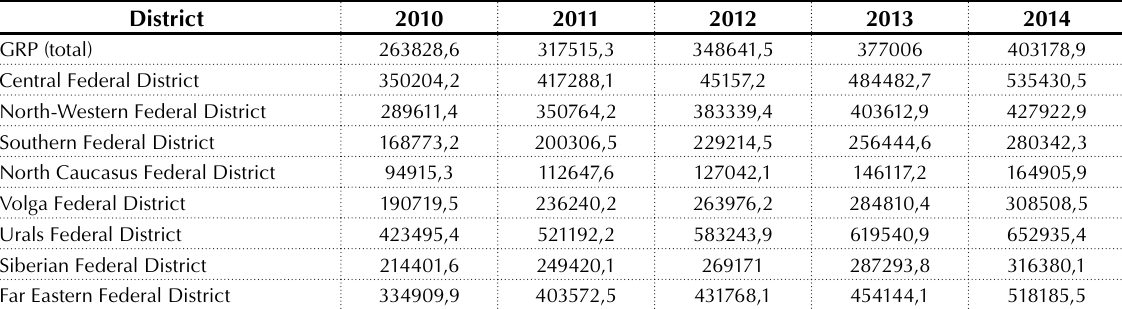
Table 2. Gross Regional Product per capita